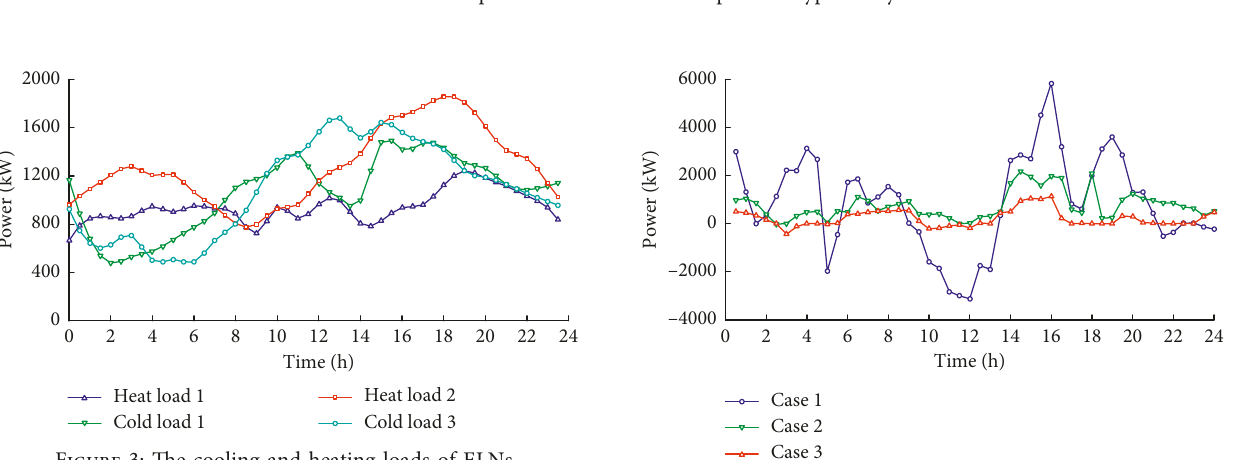
Figure 2: Active power of PV and WT output in a typical day.